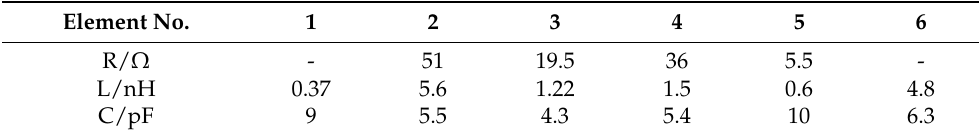
Table 2. The optimum values of the lumped elements.